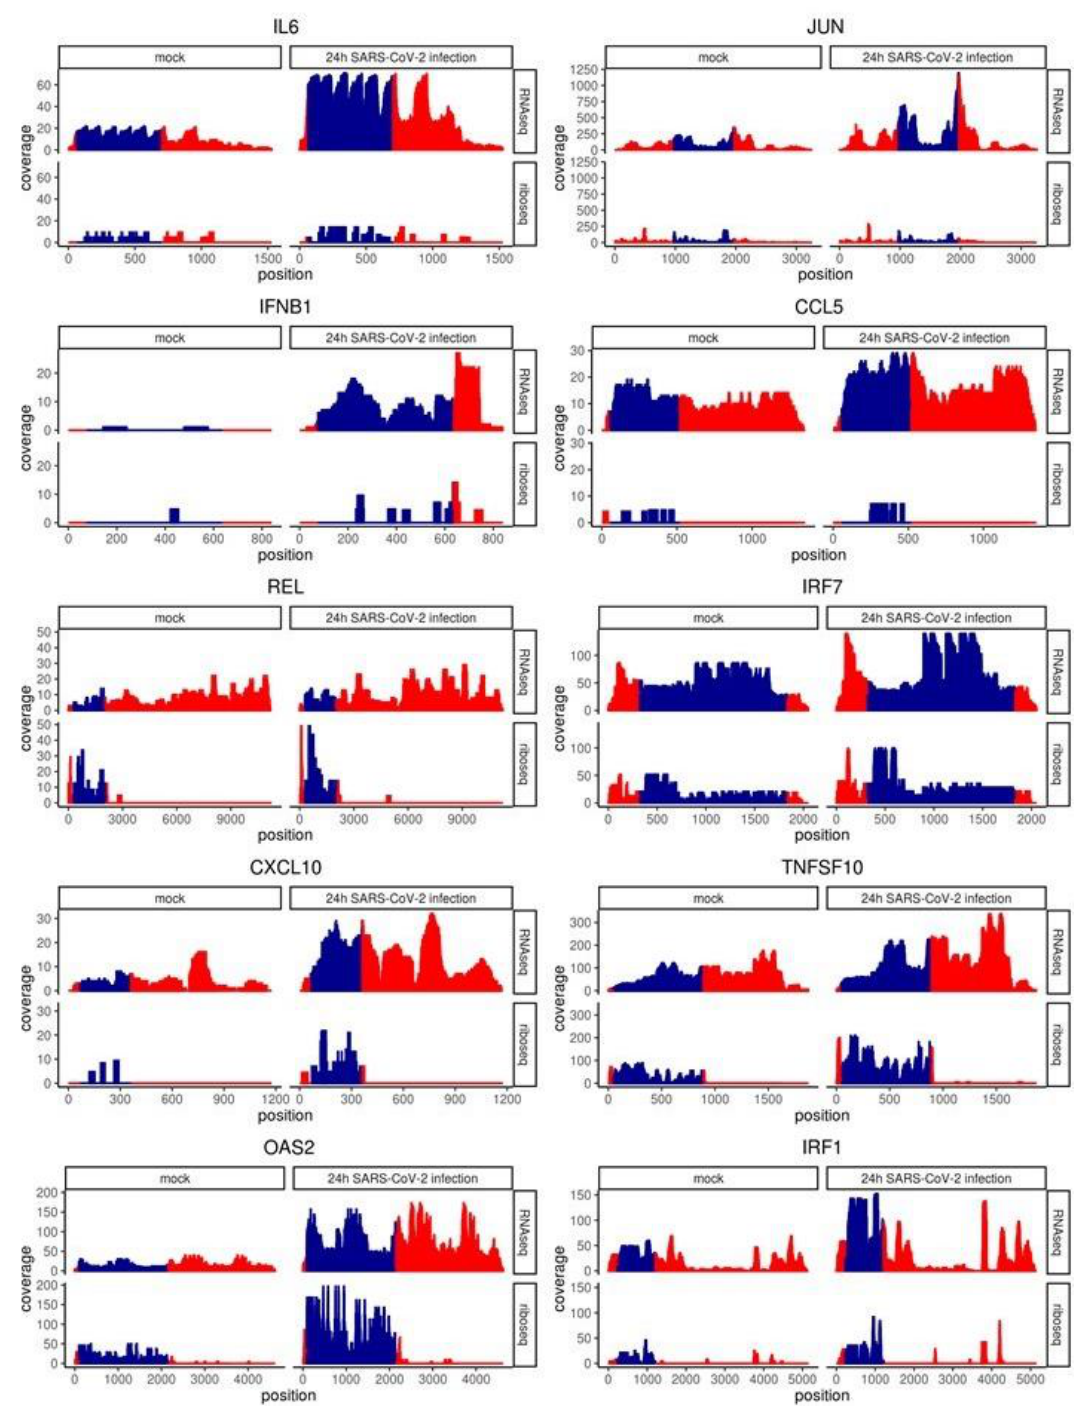
Figure 5. Coverage of select genes confirms post-transcriptional restriction of IL6, JUN, IFNB1, CCL5, REL, IRF7, CXCL10, TNFSF10, OAS2 and IRF1. Sample normalized, per nucleotide coverage statistics for indicated transcripts. Coverage values for all transcript variants were summed at each position from the transcription start site. CDS cordinates (blue) were determined using the default transcript per gene as outlined in the Matched Annotation from NCBI and EMBL-EBI (MANE) project. Red indicates 5′ ( left ) and 3′ ( right ) untranslated regions.